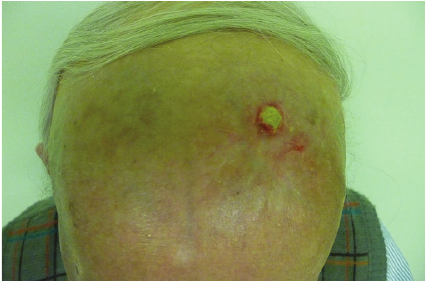
Figure 4: A localized infection of Enterobacter cloacae developed on the patient’s left forehead.